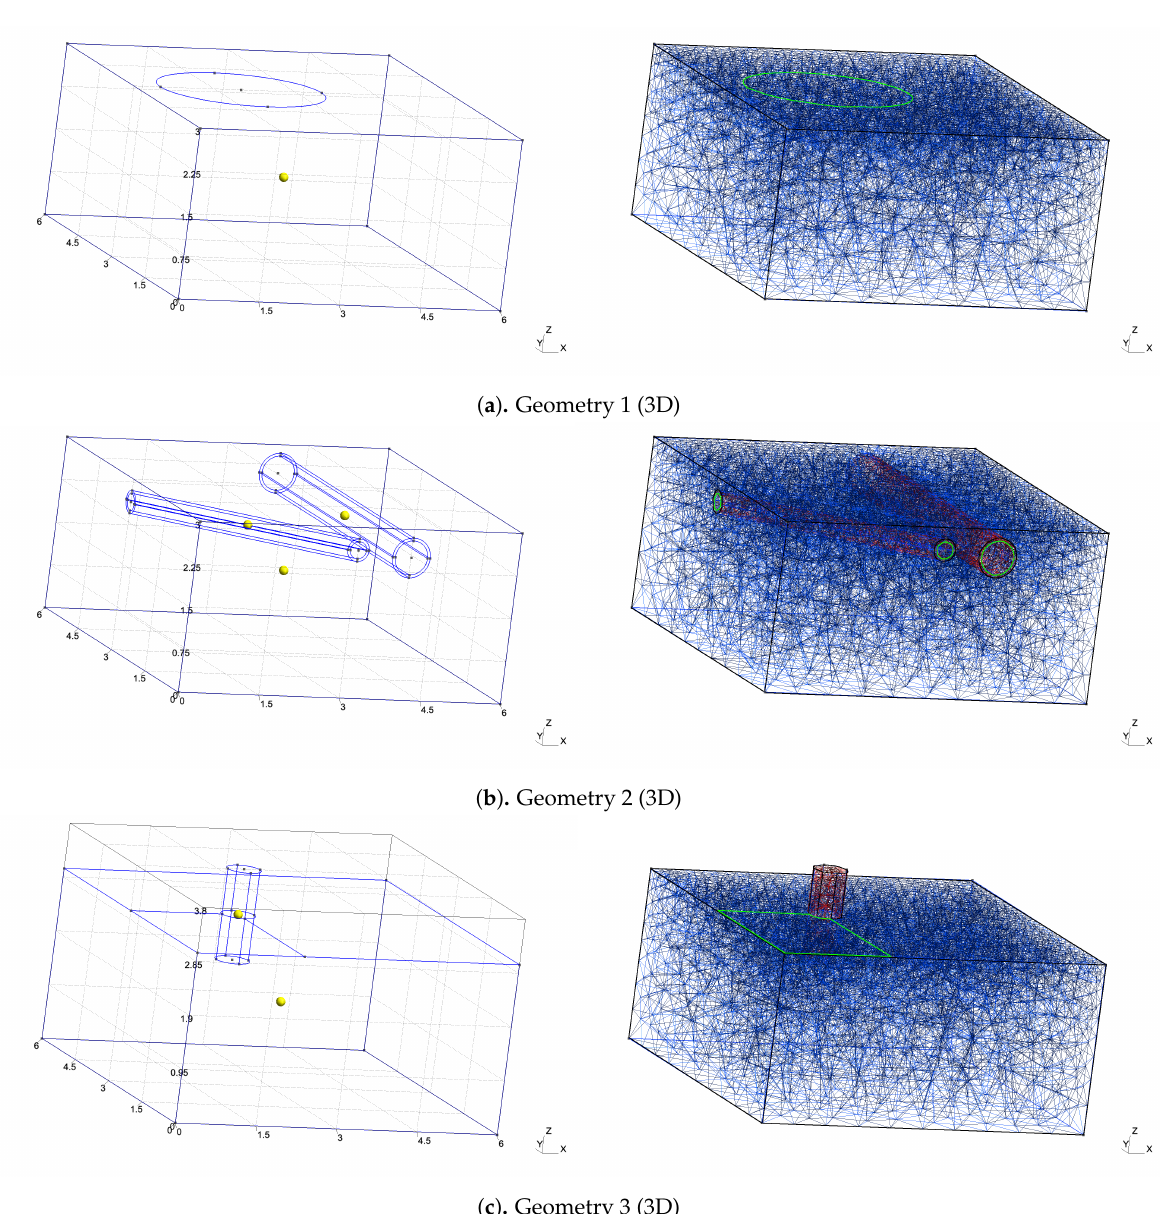
Figure 11. Computational domains and grids for three-dimensional